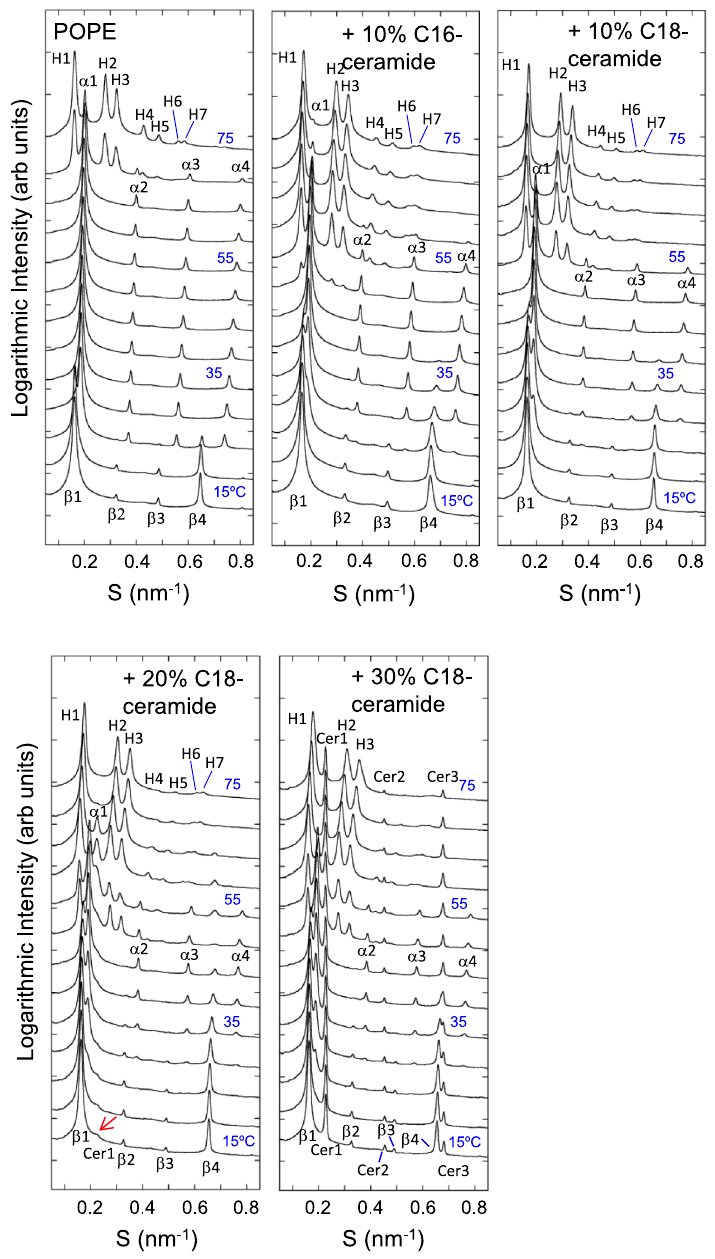
Figure 3. Small-angle X-ray scattering (SAXS) profiles obtained from POPE, POPE/10% C16-ceramide and POPE/C18-ceramide containing different amounts of C18-ceramide (10, 20, 30 mol%). Data were taken from 15 to 75 °C at 5° interval. All samples (150 mM final lipid concentration) were dispersed in 20 mM HEPES buffer (pH 7.0) containing 100 mM NaCl and 10 mM